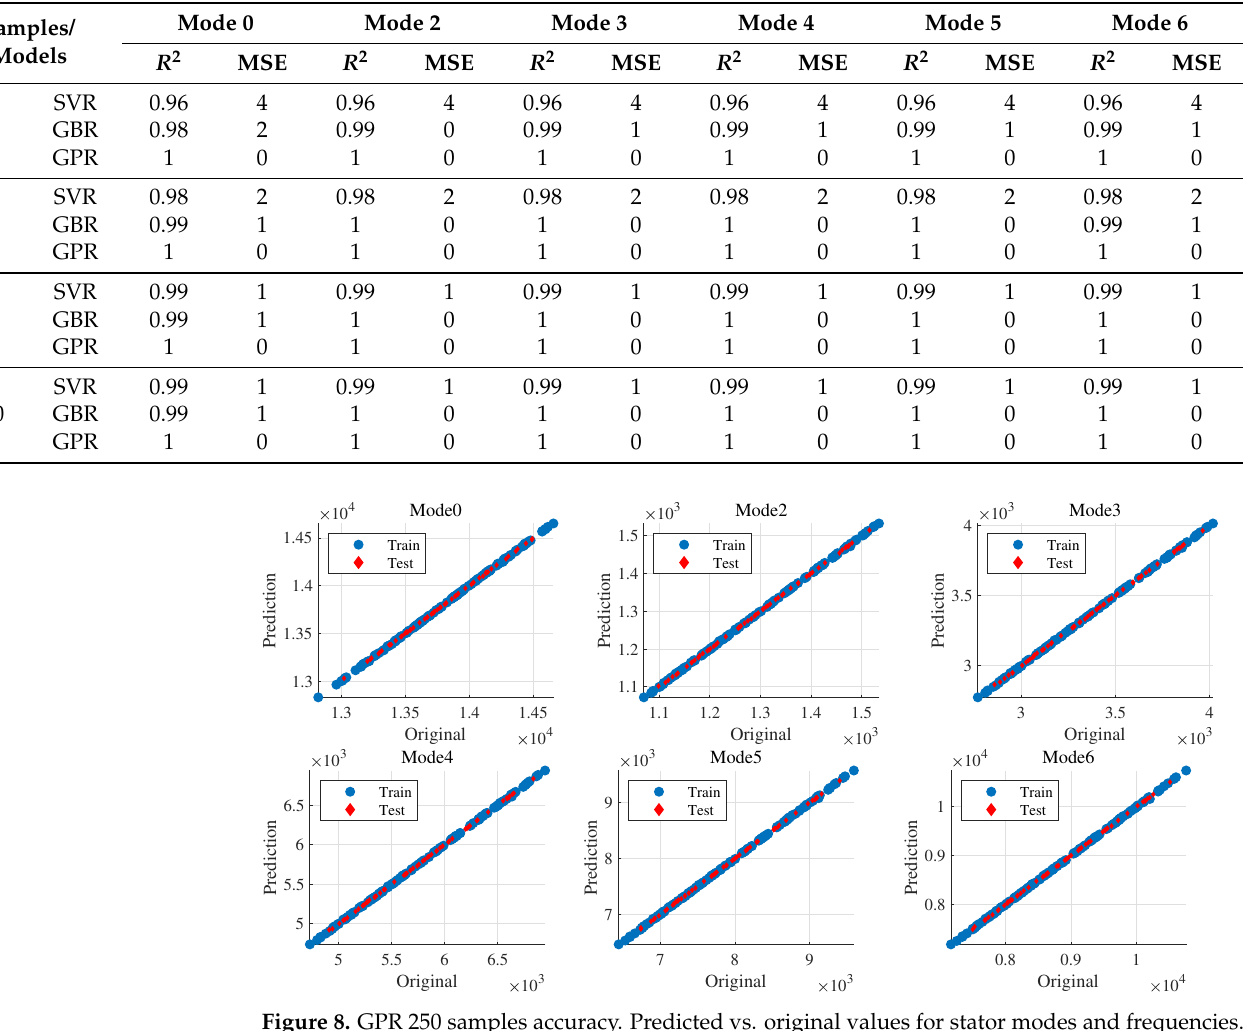
Figure 8. GPR 250 samples accuracy. Predicted vs. original values for stator modes and